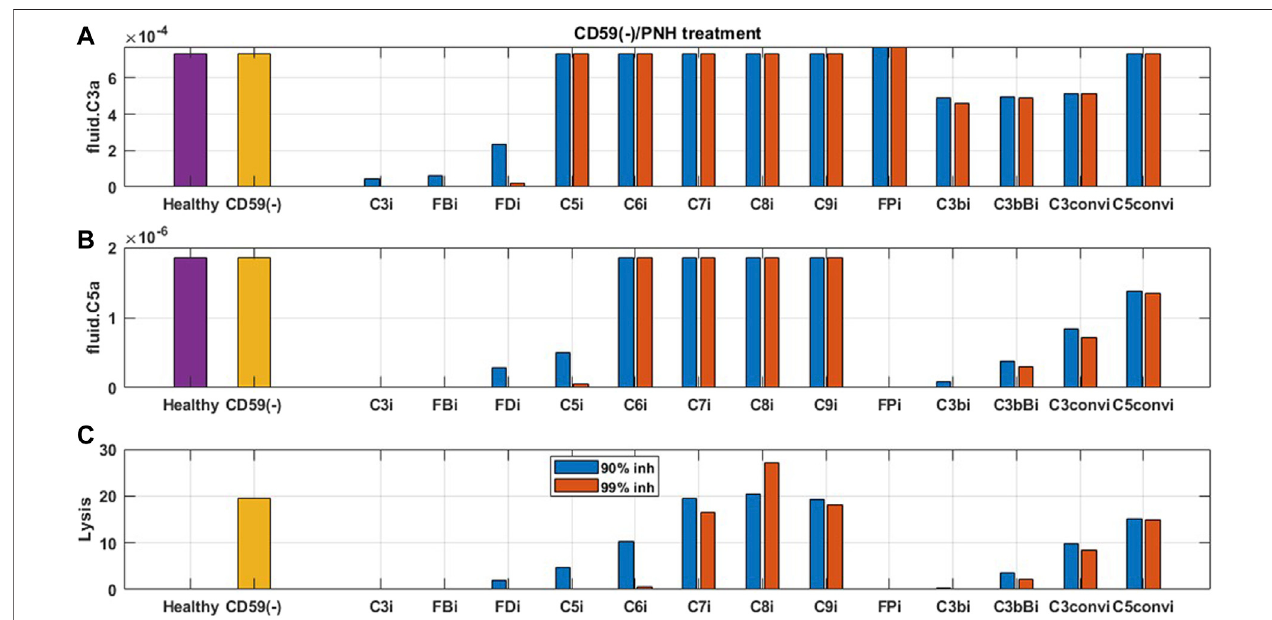
FIGURE 9 | Model predictions for the effect of 90 and 99% inhibition of complement proteins (C3, FB, FD, C5, C6, C7, C8, C9, FP, C3b, C3bB, C3-convertase (C3conv), and C5-convertase (C5conv)) on complement activation driven by CD59 de fi ciency or knockout such as in PNH disease.